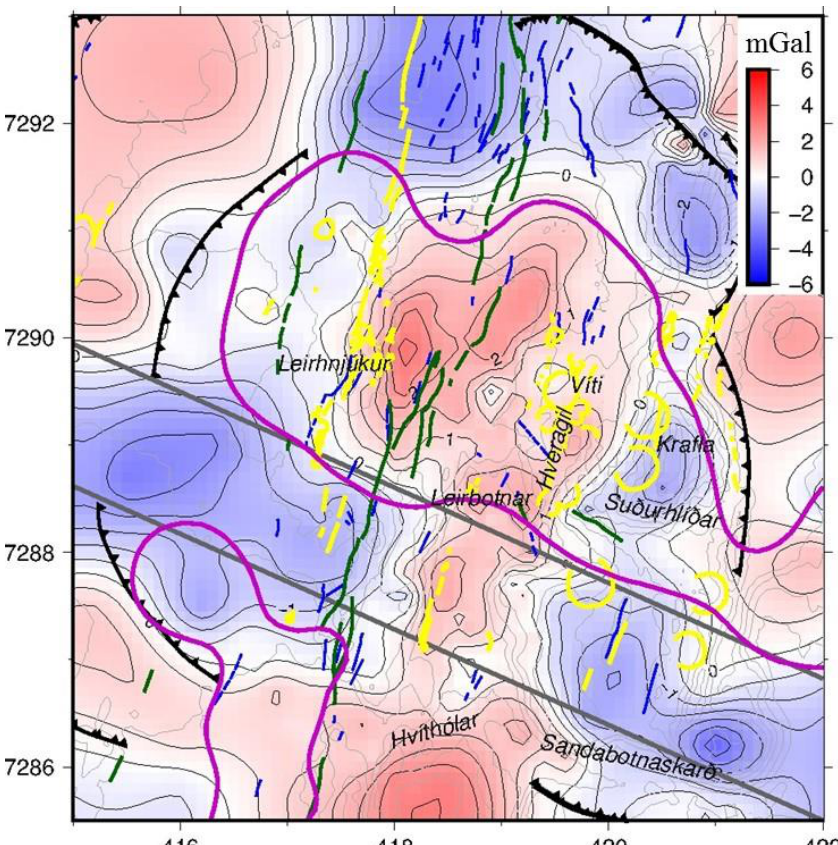
Figure 16. A zoom-in on residual Bouguer gravity in and around the inner caldera. Blue lines show faults and fissures, green lines mark the boundaries of the part of the fissure swarm that was active in the Krafla Fires and an ESE-WNW fault in the southern slopes of Mt. Krafla that moved in the Krafla Fires. Yellow arcs and lines show explosion craters and eruptive fissures. Note, the abundant explosion craters west and south of Mt. Krafla. Grey lines mark the transverse structure and purple lines mark the extent of high-temperature alteration at 200 m a.sl. (from Figure 9). Coordinates are UTM WGS84 zone 28 in km.